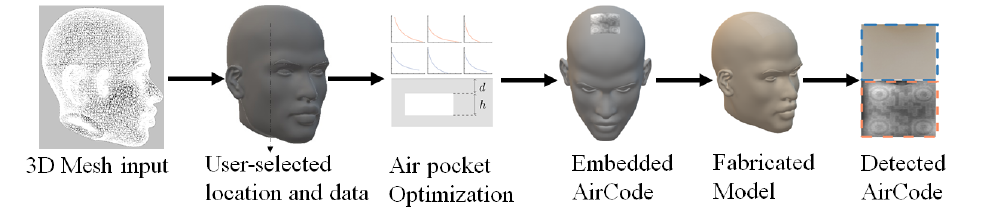
Figure 8. AirCode pipeline